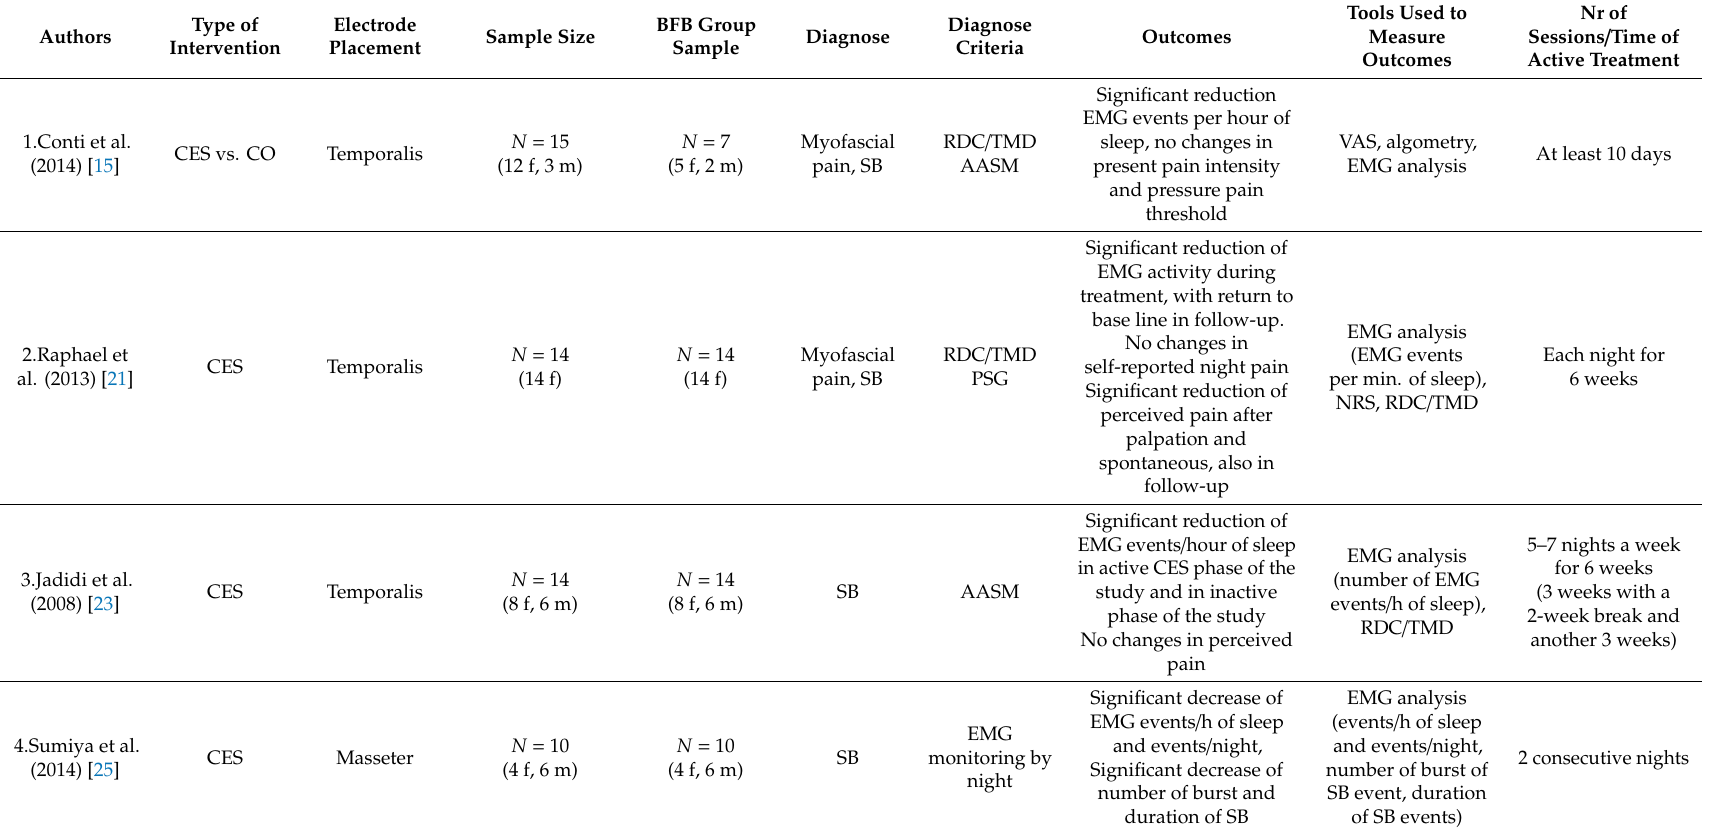
Table 2. Summary of included studies using contingent electrical